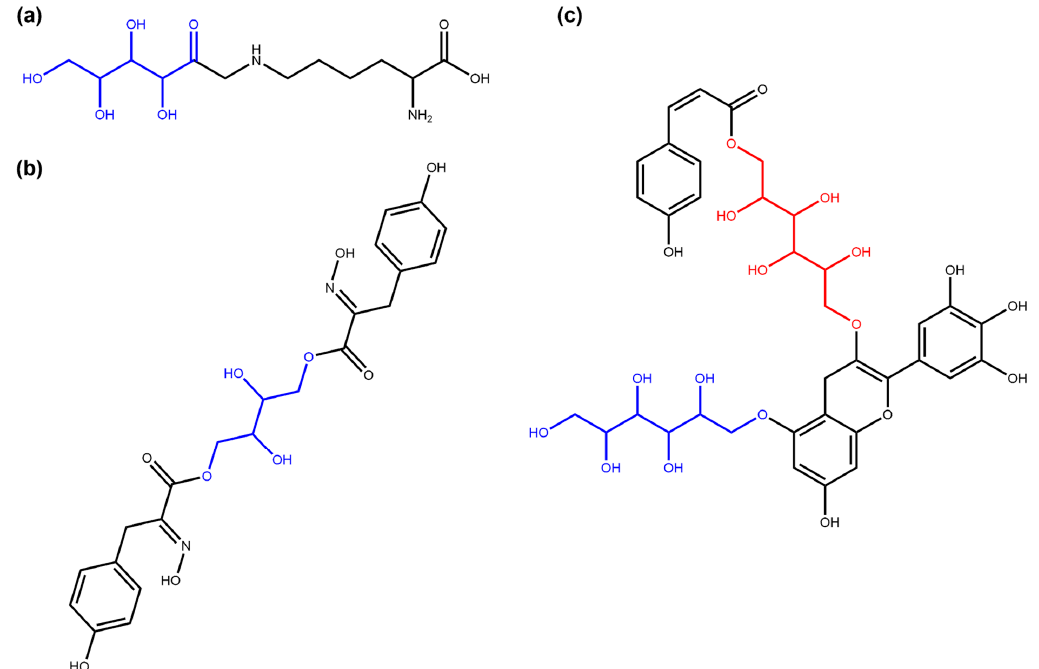
Figure 6. Examples of the terminal and non-terminal linear sugars identified in COCONUT NP. ( a ) Fructosyllysine (COCONUT ID CNP0082897), a terminal linear fructosyl moiety (in blue) attached to lysine. ( b ) Aspergillusol A (CNP0290091), a tyrosine-derived metabolite with a central non-terminal linear sugar (tetraol, in blue) structure [31]. ( c ) COCONUT NP CNP0321545, one of the two NPs in COCONUT with both terminal (in blue) and non-terminal (in red) linear sugar moieties in their structure.